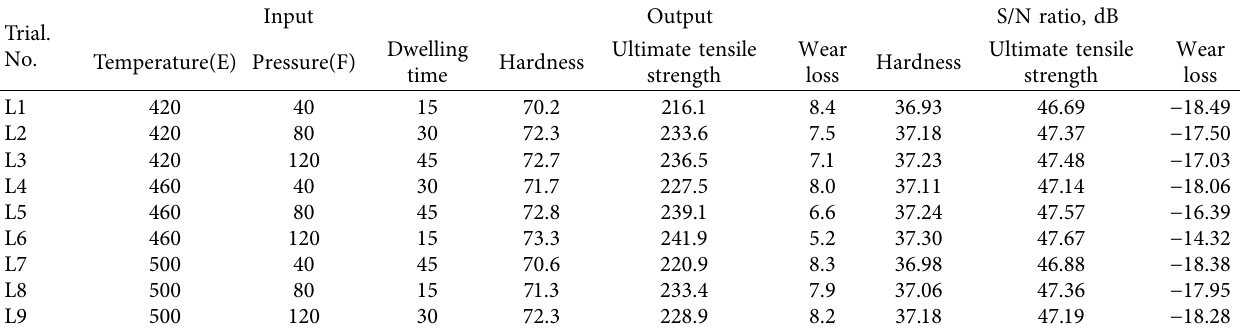
Table 7: Hot-pressing progression’s experimental input and output setting.